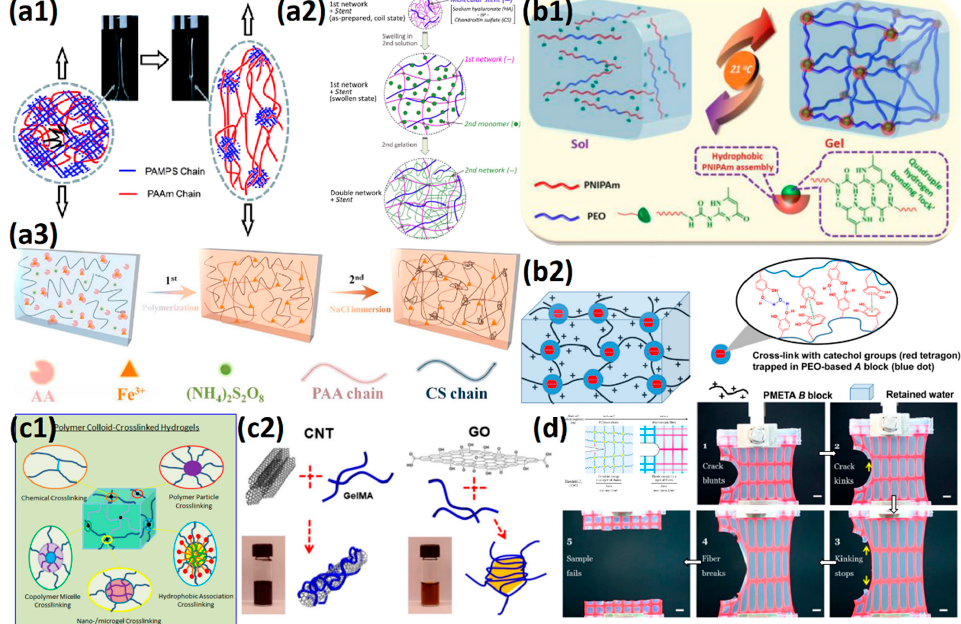
Figure 2. Methods to strengthen hydrogels based on enhancing mechanical energy dissipation: ( a ) double network hydrogels with rigid chemical cross-linked polyelectrolyte 1st network and soft 2nd network (a1), hydrophilic molecular stent filled both neutral 1st and 2nd networks (a2) and non-covalent cross-linked 1st and 2nd networks (a3). Reproduced with permission from [5] (Copyright